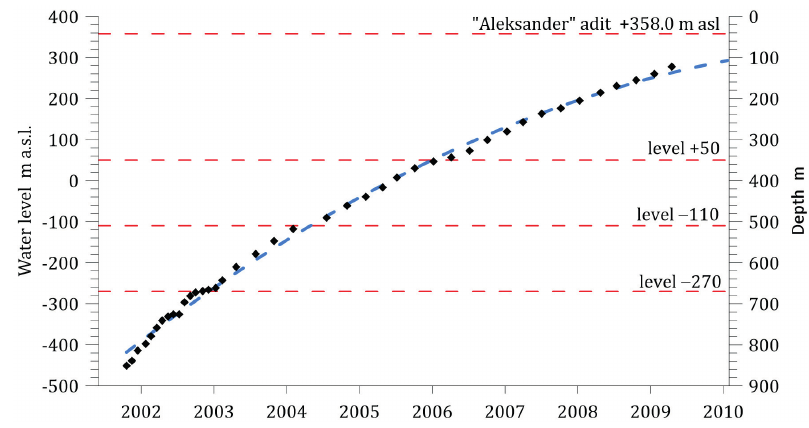
Figure 5. Water table rebound in “Nowy I” shaft (Adapted from Chudy [39]).